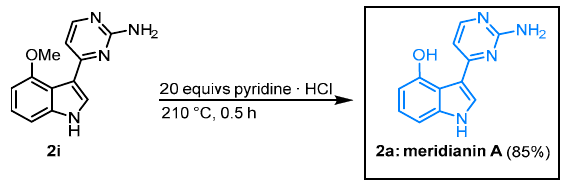
Figure 17. Synthesis of meridianins by Müller via MBSC sequence [63,64].